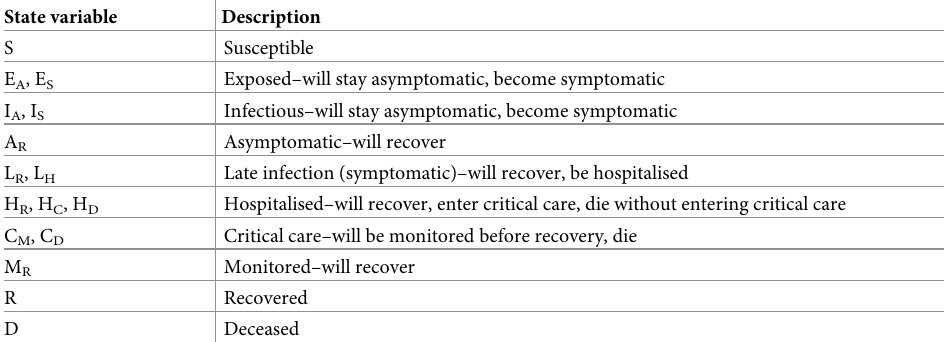
Table 2. State variables for the compartmental